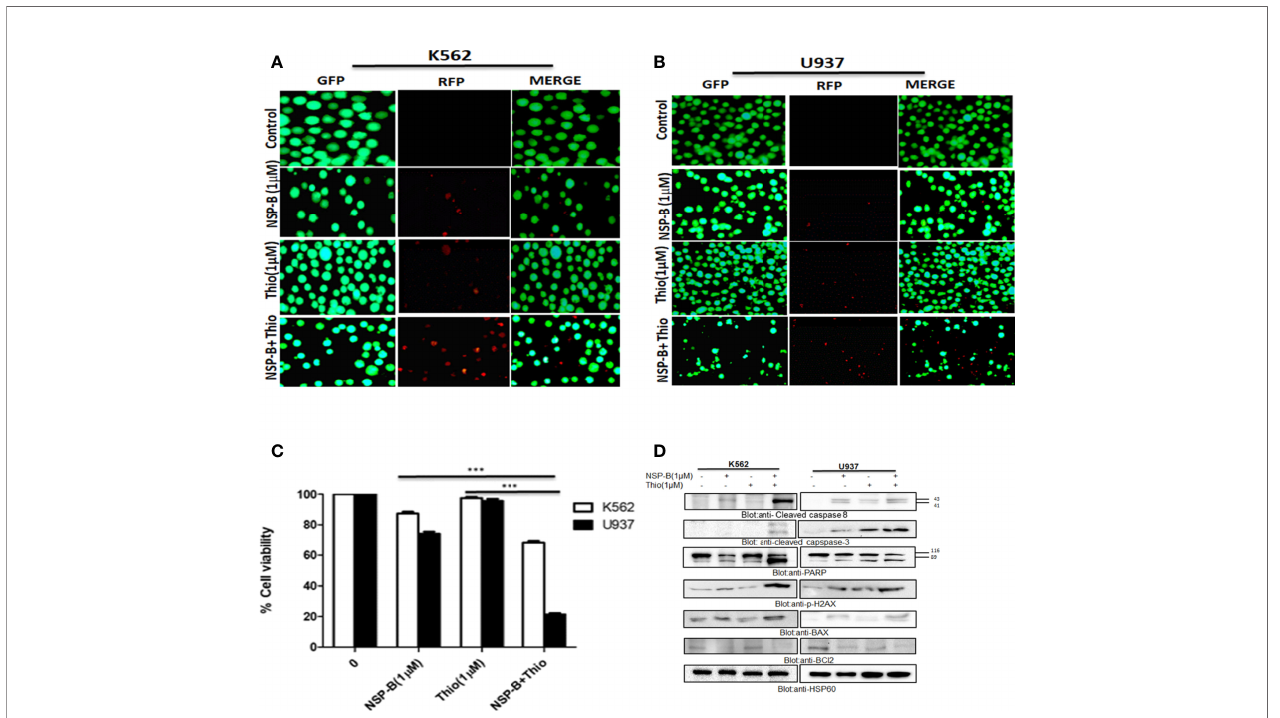
FIGURE 7 | Cotreatment of NSP-B and thiostrepton augmented the inhibition of cell viability and induces apoptosis in leukemic cells. (A) K562 and (B) U937 were treated with NSP-B and thiostrepton alone and in combination for 48 hours. After incubation the cells were stained with live and dead reagent and visualized under a fl uorescent microscope. (C) K562 and U937 cells cells were treated with 1µM of NSP-B and 1µM of thiostrepton for 48 hours and cell viability assay was performed as mentioned in Materials and Methods. The graph displays the mean ± SD (standard deviation) of three independent experiments. ***p < 0.001. (D) K562 and U937 were treated with 1 µM of NSP-B and thiostrepton alone and in combination and cells were lysed and separated using SDS-PAGE, transferred to a PVDF membrane, and immunoblotted with antibodies such as PARP, cleaved caspase-8, cleaved caspase-3, BAX, Bcl-2, P-H2AX, and